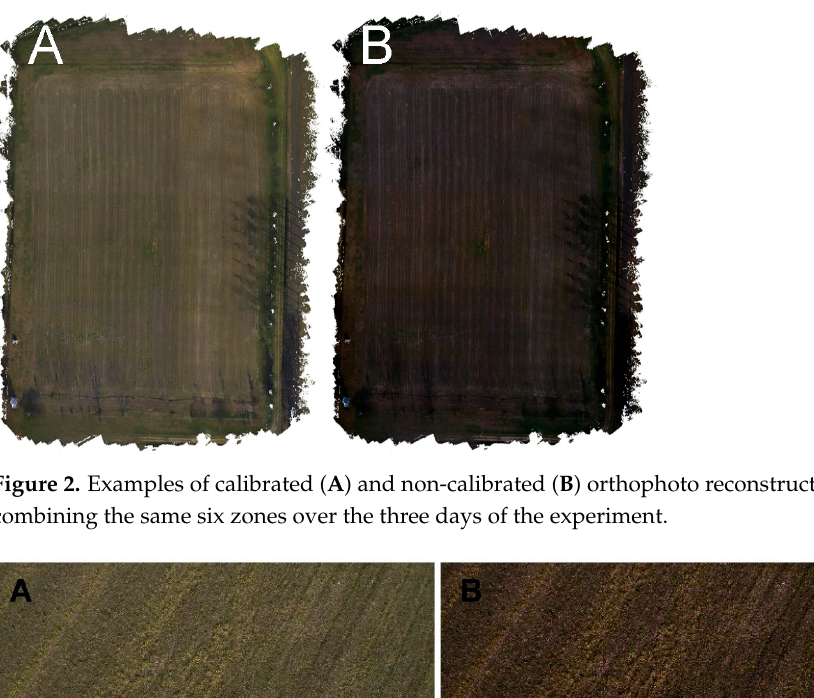
Figure 4. Examples of non-calibrated orthophoto reconstructed with images of the same day (day 1) ( A ), and randomly combining the same six zones over the three days of the experiment ( B ). Differences between the parameters obtained after orthophoto reconstruction from calibrated and non-calibrated reconstructions are reported in Table 3. It is possible to observe how parameter reporting errors are always lower in the calibrated reconstructions and the other quantitative parameters are always lower in the non- calibrated ones. Considering that the paired comparison (Wilcoxon test) was only conducted on 15 reconstructions, it is still possible to observe significant ( p < 0.05) differences in the percentage of camera stations on the total number of images and the Reprojection error. Table 3. Mean (±SD) values of the parameters obtained after orthophoto reconstruction. Differences between the calibrated and non-calibrated reconstructions. Means with the same letter are not significantly different (Wilcoxon paired test). Parameters